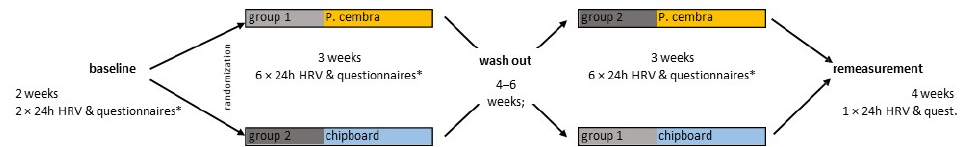
Figure 1. Measure protocol and study design. *. Scales (questionnaires; quest.): PSQI [30], SRS HRI [32], BBS [31] and RSTQ-Basic-24 [33,34].